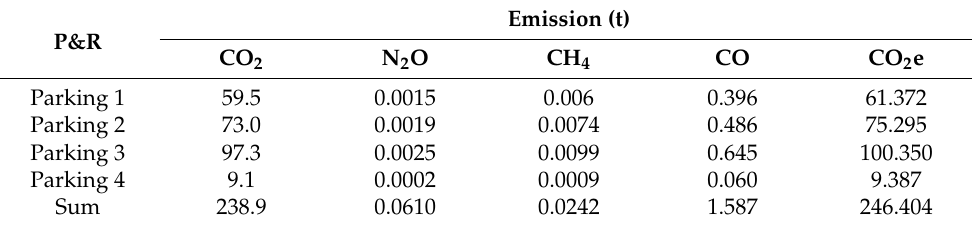
Table 6. Greenhouse gas emission calculation results from passenger cars in variant